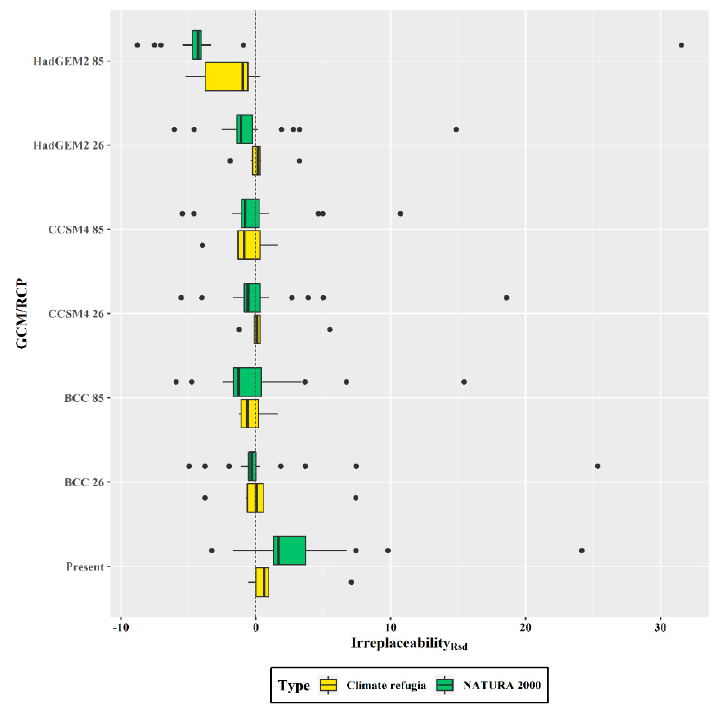
Figure 7. Mean irreplaceability index standardised for area, for the protected area network (Natura 2000 sites) and climatic refugia in Crete, for the current and all the Global Circulation Model (GCM) and Representative Concentration Pathway (RCP) combinations considered in our study. The vertical dashed line represents the median irreplaceability index.